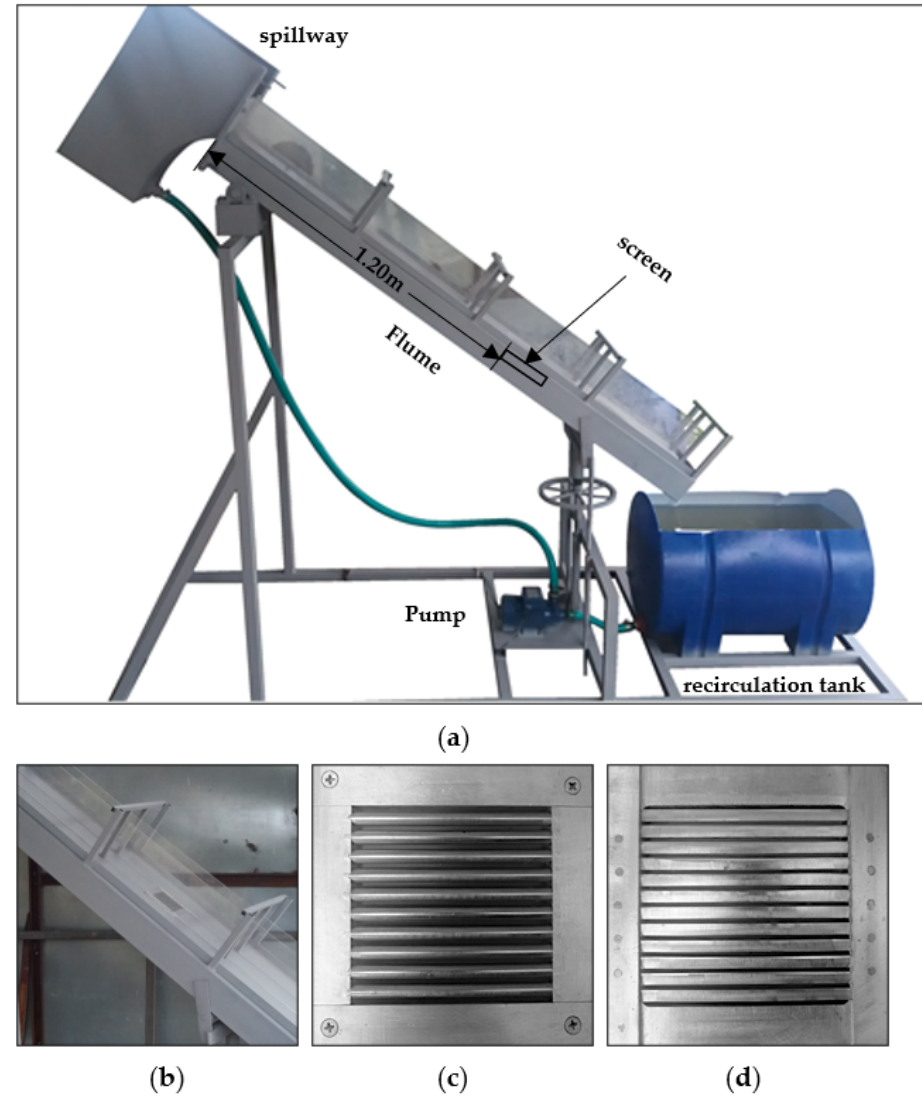
Figure 2. ( a ) Variable ‐ slope screen testing flume; ( b ) screen installed in the test flume; ( c ) test screen triangular wire ( d ) test screen circular wire. Table 1. Geometric Features of the Test Screens